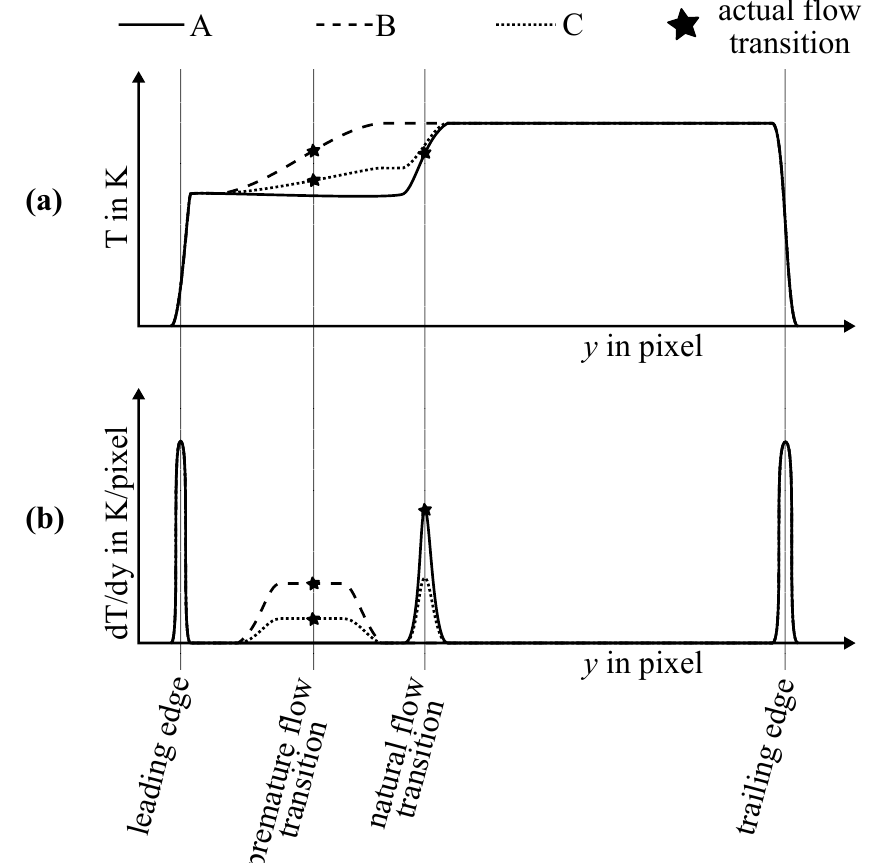
Figure 2. Sketch of ( a ) the temperature profile and ( b ) the temperature gradient of the three evaluation lines A, B, and C in Figure 1. The star-symbol marks the location of the actual flow transition. The flat temperature rise in the profile B with a premature flow transition results in a lower gradient compared to the profile A and therefore has a lower sensitivity with respect to the flow transition position. For the low-contrast turbulence wedge example C, the location of the flow transition does not correspond with the global but a local gradient maximum, which is lower than for a strong turbulence wedge